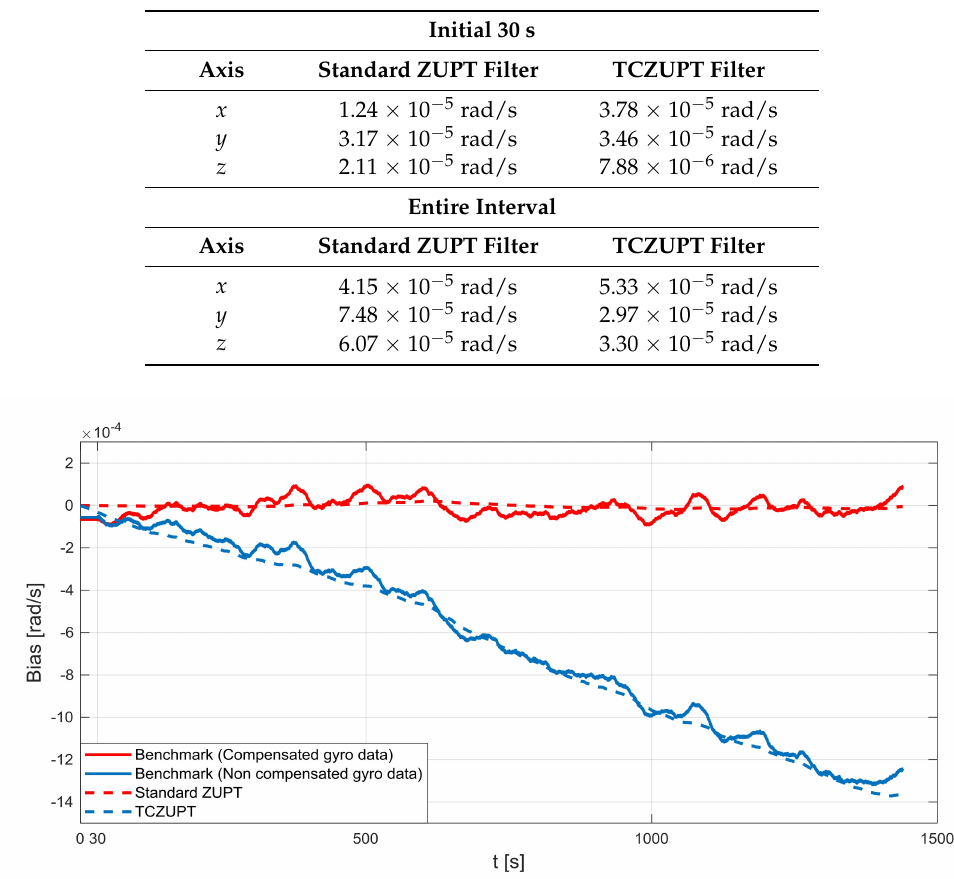
Table 6. Root Mean Squared Error (nominal conditions).